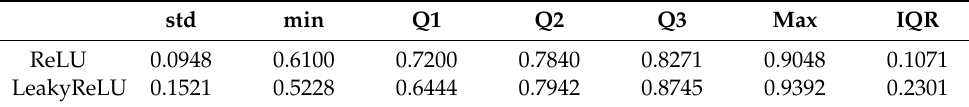
Figure 8. Distribution desity map of different activation functions. Table 1. The AUC value comparison of using LeakyReLU and RELU